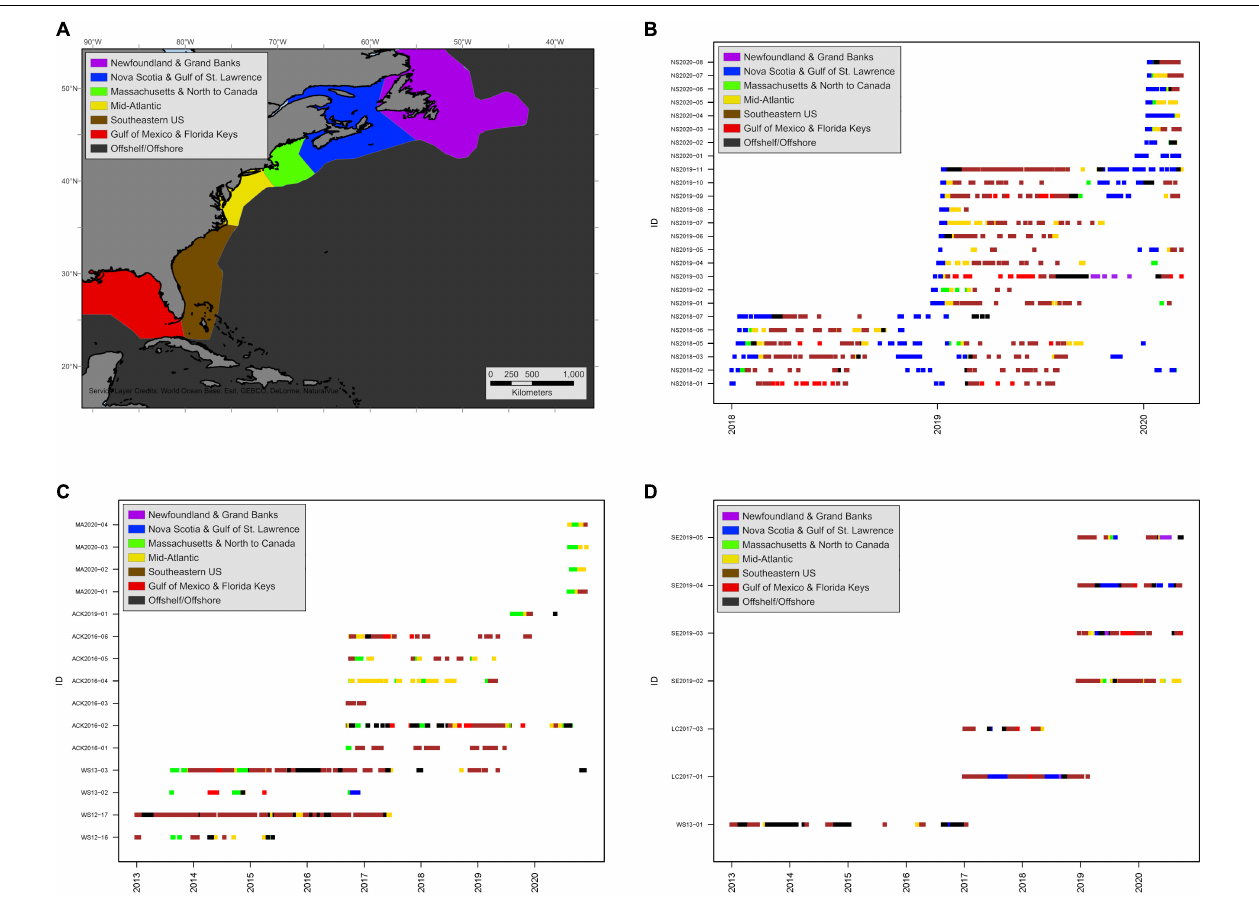
FIGURE 10 | Abacus plots of raw SPOT and acoustic locations of all white sharks colored by region of location or detection ( A: Map of regions denoting color of region; B: Nova Scotia caught sharks; C: Massachusetts caught sharks; D: SE United States caught sharks). On-shelf regions (all except offshelf/offshore) extend from the shoreline to the shelf break with a 50 km buffer. Regions include: Newfoundland and Grand Banks (purple), Nova Scotia and Gulf of St. Lawrence (blue), Massachusetts and north to Canadian EEZ (green), mid-Atlantic (gold), southeastern United States (brown), Gulf of Mexico and Florida Keys (red), and offshelf/offshore (black). Sharks captured/tagged in Nova Scotia (B) were less likely to be detected in subsequent years in waters near Massachusetts (green) and more likely to be detected in Canadian waters (blue or purple). Conversely, sharks captured/tagged in Massachusetts (C) were less likely to be detected in subsequent years in Canadian waters (blue or purple) and more likely to be detected back in waters near Massachusetts (green). Of the Southeastern shelf caught sharks (D) , there were preferences to utilize one or the other summer/autumn region (blue/purple or green) in subsequent years of tracking but usually not both. During overwintering periods, sharks with detections in the Gulf of Mexico (red) were likely to have detections in the Gulf of Mexico in subsequent overwintering